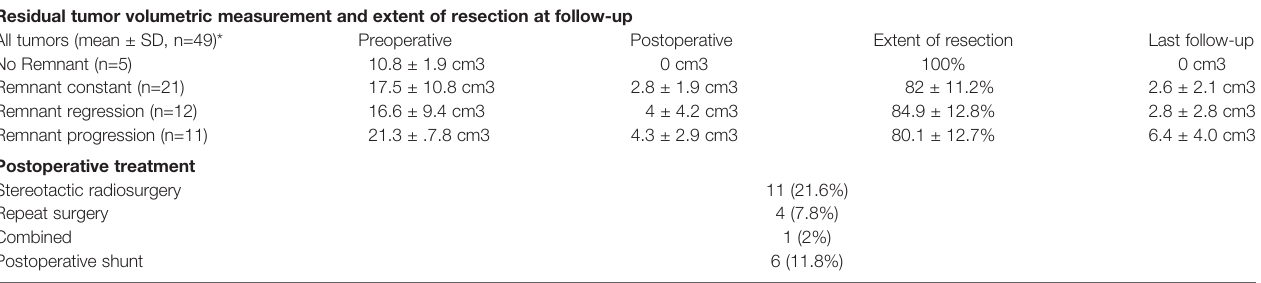
*2 Patients with documented progression of a tumor remnant were lost to follow-up after the fi rst follow-up.